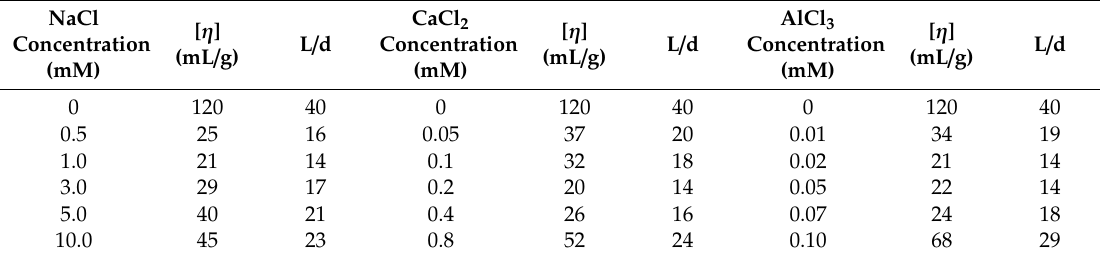
Table 3. Intrinsic viscosities of CNC-A suspensions and calculated aspect ratio of CNC with various NaCl, CaCl 2 , and AlCl 3